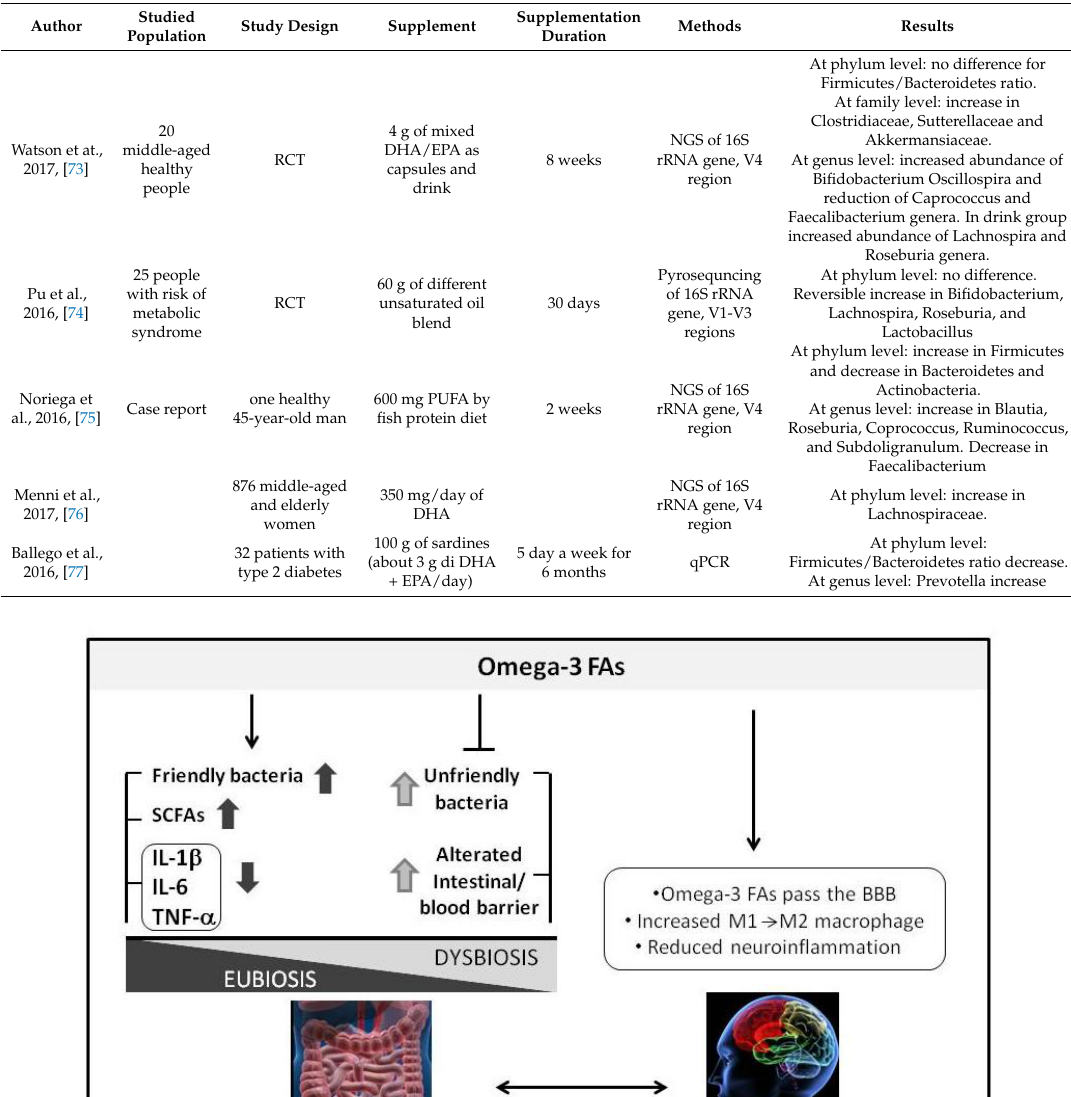
Table 1. Studies investigating the omega-3 fatty acid influence on human gut microbiota.